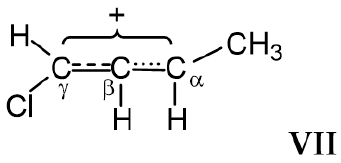
Scheme 8. Structure of isomer VII according to NMR and IR spectroscopy.